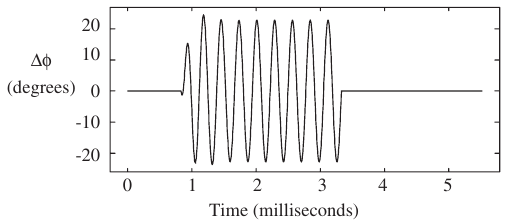
FIG. 16. Modulation waveform used for simulations. FIG. 15. (Color) Result of Gaussian fits of streak camera images.